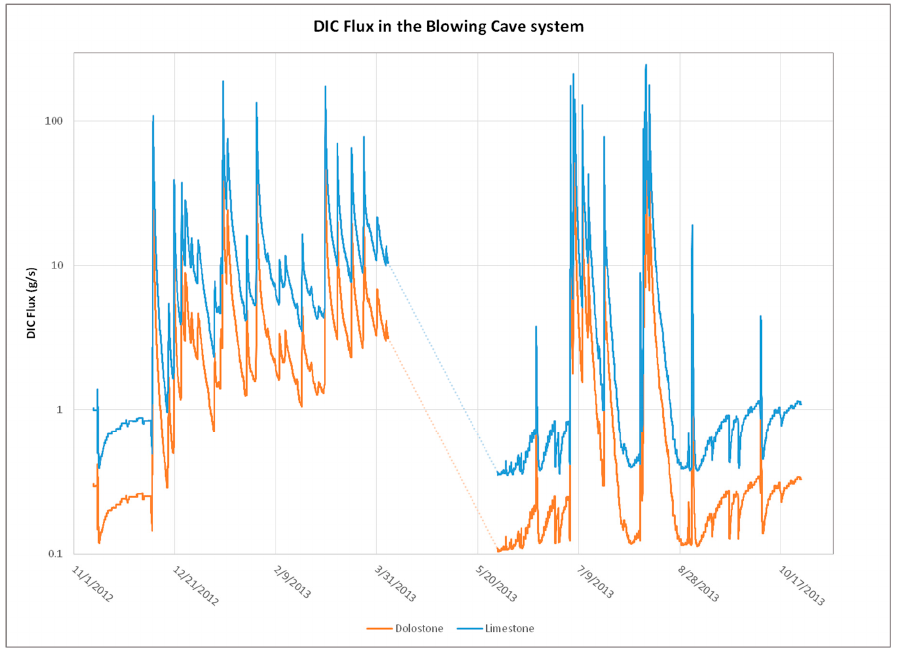
Figure 3. Flux of dissolved inorganic carbon through for the Blowing Cave Kentucky system. The gap in the modeled flux is from the lack of SpC logs from instrument downtime.